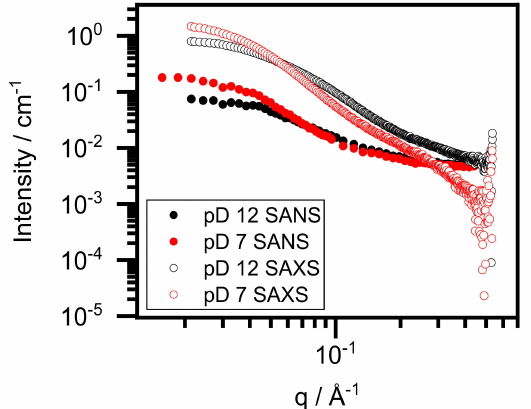
Figure 3. Small-angle X-ray and small-angle neutron scattering curves of BSA–Au conjugates at pD ~12 and pD